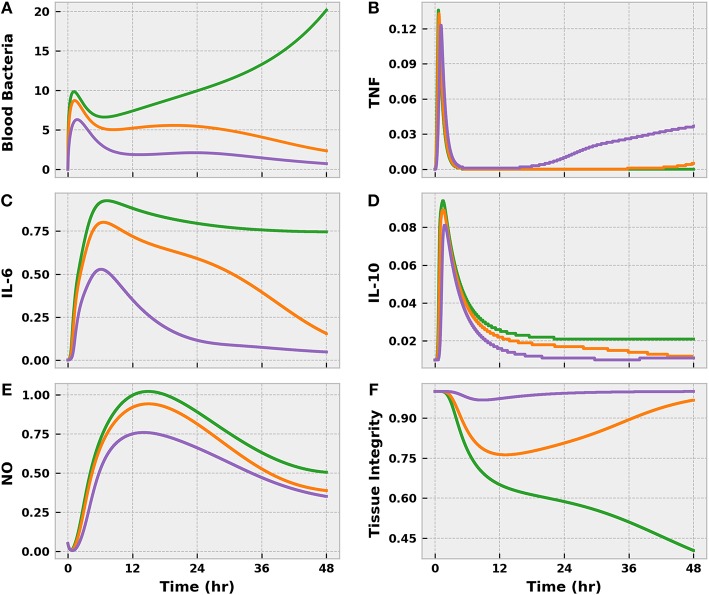
The progression of the acute inflammatory response model when the BioGears Infection action is simulated for 48 h at the three different severities: mild (purple), moderate (orange), and severe (green). These Infection action levels correspond to initial tissue bacteria counts of 1e6, 5e6, and 1e7, respectively. Selected outputs are (A) blood bacteria population, (B) TNF count, (C) IL-6 count, (D) IL-10 count, (E) NO count, (F) and Tissue Integrity. All units are in arbitrary concentration except for Tissue Integrity, which is dimensionless. Mild and Moderate infections demonstrate some infiltration of bacteria to the blood stream, but the levels are brought under control by the action of neutrophils recruited by inflammatory mediators IL-6 and TNF. Overall, the system exhibits an appropriate balance between pro- and anti-inflammatory (IL-10) activities with minor implications for tissue health. In the severe case, the bacteria population in the blood grows unchecked and pro- and anti-inflammation become imbalanced, leading to excessive and prolonged inflammation. When pro-inflammatory activity is not curtailed, the tissue accrues additional damage.